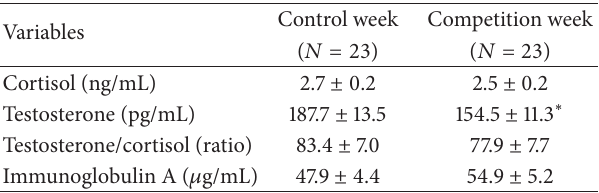
Table 2: Salivary concentrations of hormonal and immune markers for the control and the competition week in adolescent swimmers (mean weekly values ±